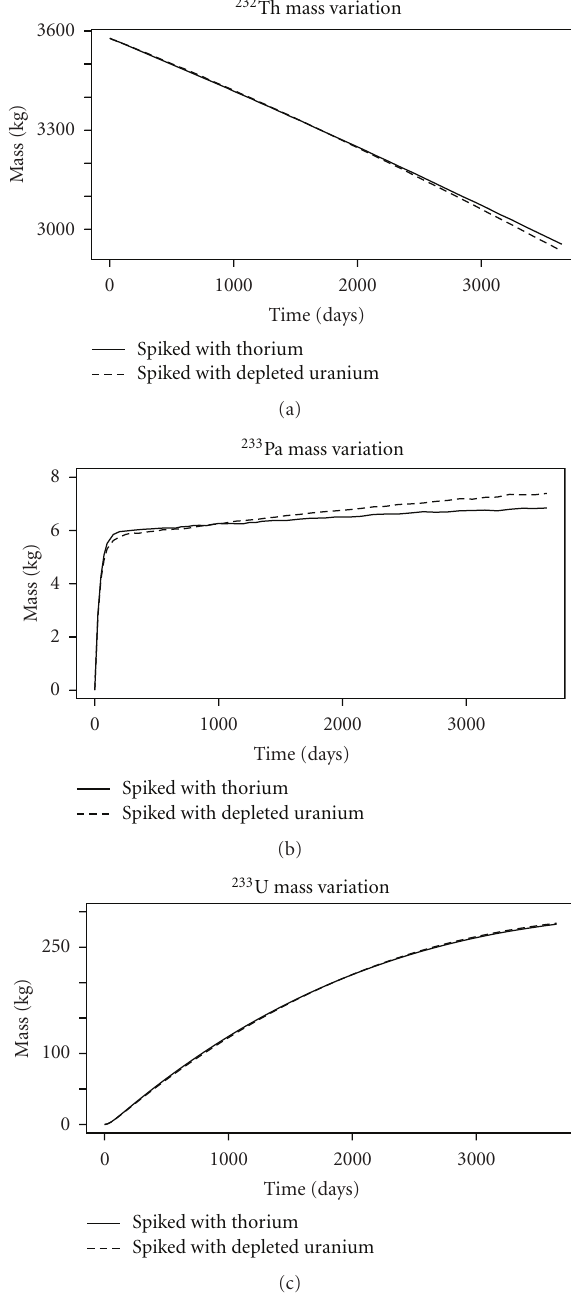
Figure 5: 232 Th, 233 Pa, and 233 U mass